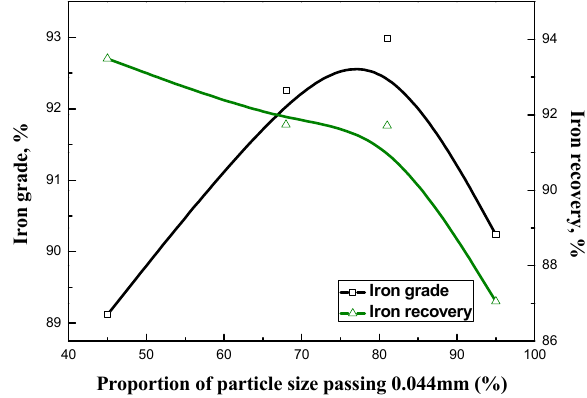
Figure 7. Effect of grinding fineness on iron grade and iron recovery of magnetic concentrate (borax dosage of 5%, and reducing at 1050 °C for 80 min).